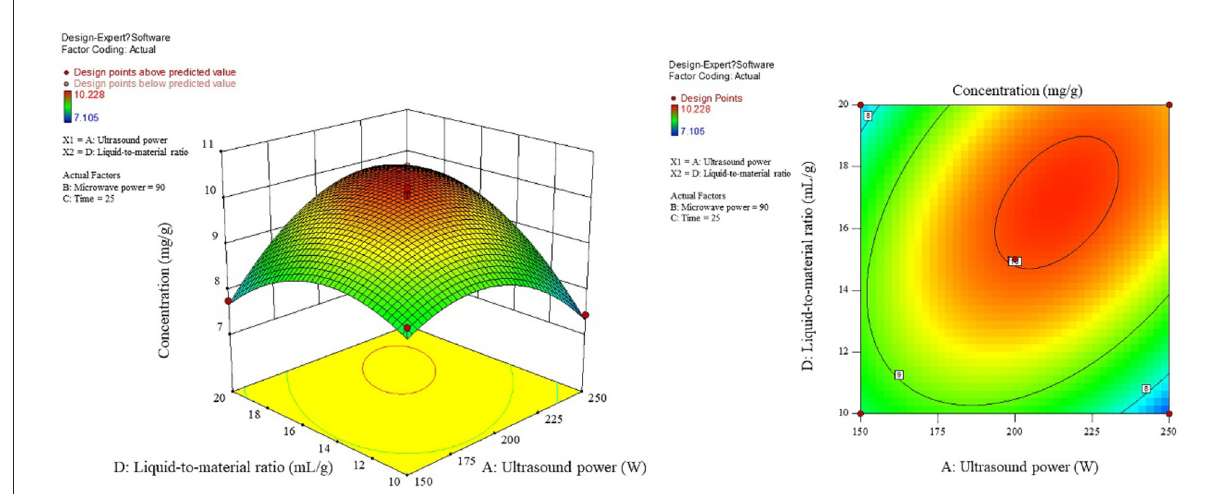
FIGURE5 Effect of the interaction of ultrasonic power and liquid-to-material ratio on content.